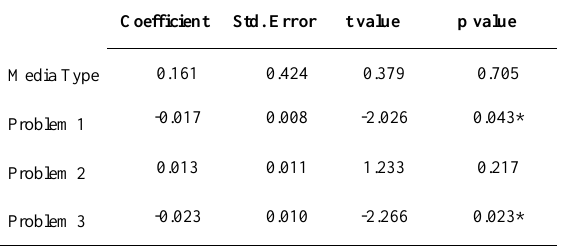
coefficients indicated that participants with lower